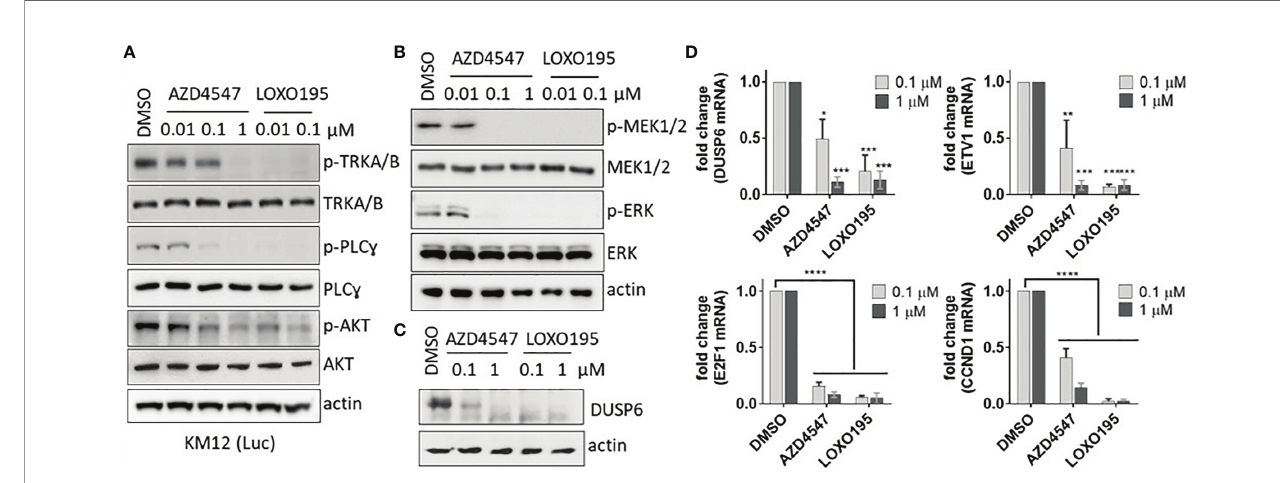
FIGURE 3 | AZD4547 suppresses phosphorylation of TRKA/B and its downstream substances. (A) AZD4547 inhibits phosphorylation of TRKA/B, PLC-gamma and AKT in KM12(Luc). The phosphorylation level of TRKA/B, PLC-gamma and AKT were monitored after 2 h treatment with AZD44547 or LOXO195. Data are representative of two independent experiments. (B) AZD4547 decreases MAPK signaling in KM12(Luc). AZD4547 or LOXO195 treated for 2 h against KM12(Luc). Level of phospho- MEK1/2 and ERK1/2 were evaluated by western blot. Data are representative of two independent experiments. (C) AZD4547 treatment reduces the DUSP expression level in KM12(Luc). After 24 h treatment with the indicated substances, the cell lysates were subjected to western blot with DUSP6 antibody. Data are representative of two independent experiments. (D) AZD4547 blocks the MAPK and E2F pathways. After treatment of AZD4547 or LOXO195 for 24 h, total RNA was extracted, and cDNA was synthesized. Each cDNA was ampli fi ed by using the indicated primer for comparison of mRNA levels. (average ± SEM, n=3, twoway Anova, * < 0.05, ** < 0.005, *** < 0.001, ****p <